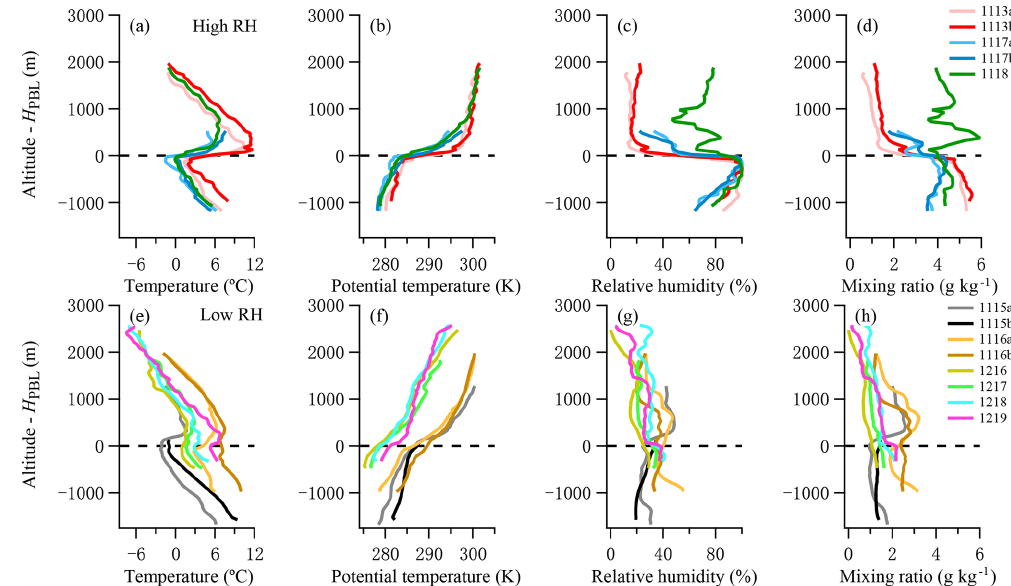
Figure 2. Vertical profiles of in situ measured meteorological parameters under high RH and low RH conditions during the experiment; y axis denotes the above-sea-level height relative to the planetary boundary layer